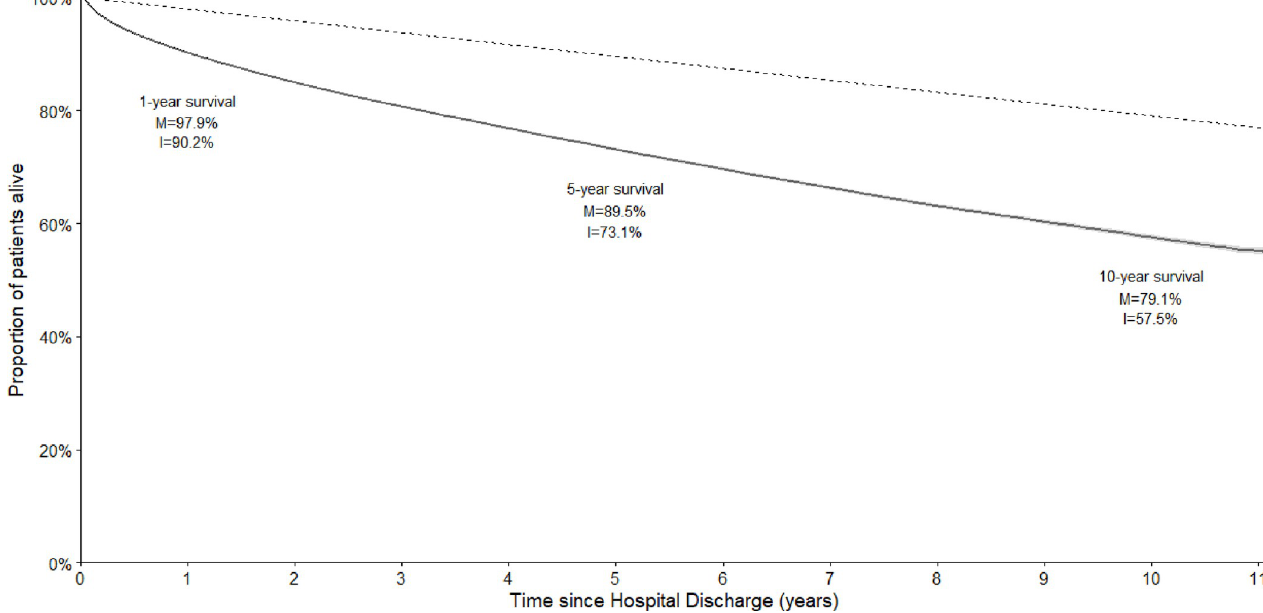
Fig 1. Survival curve of the study cohort (solid line) compared to the matched cohort (dotted line) (N = 130707). I; Intensive Care cohort, M; Matched cohort. The 95% confidence interval of the study cohort line is represented by the shaded area.